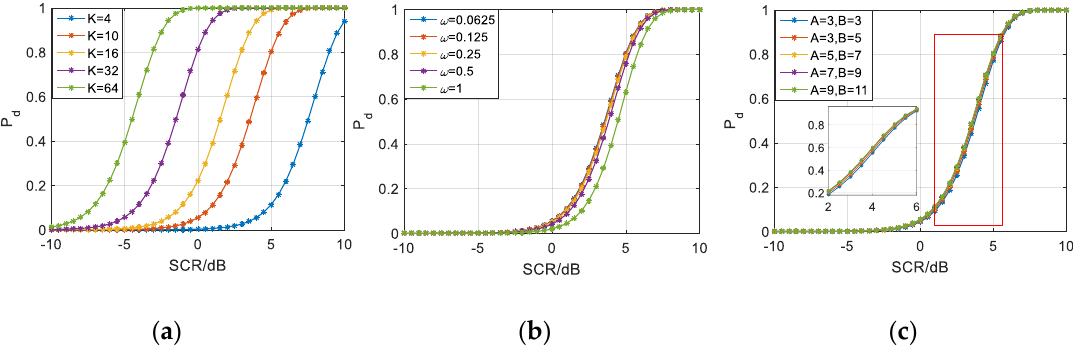
Figure 11. Theoretical 𝑃 𝑑 of CA-CM-CFAR in homogeneous background: ( a ) 𝐴 = 7 , 𝐵 = 9, 𝜔 =